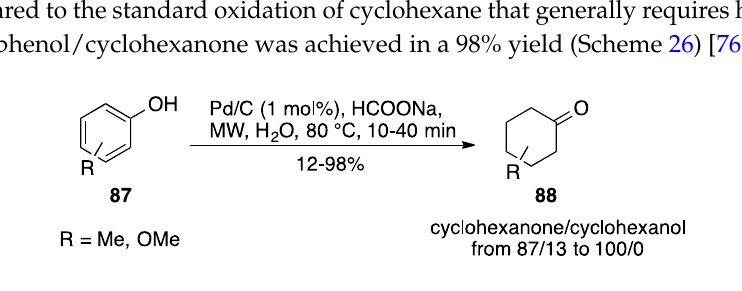
Scheme 26. Reduction of